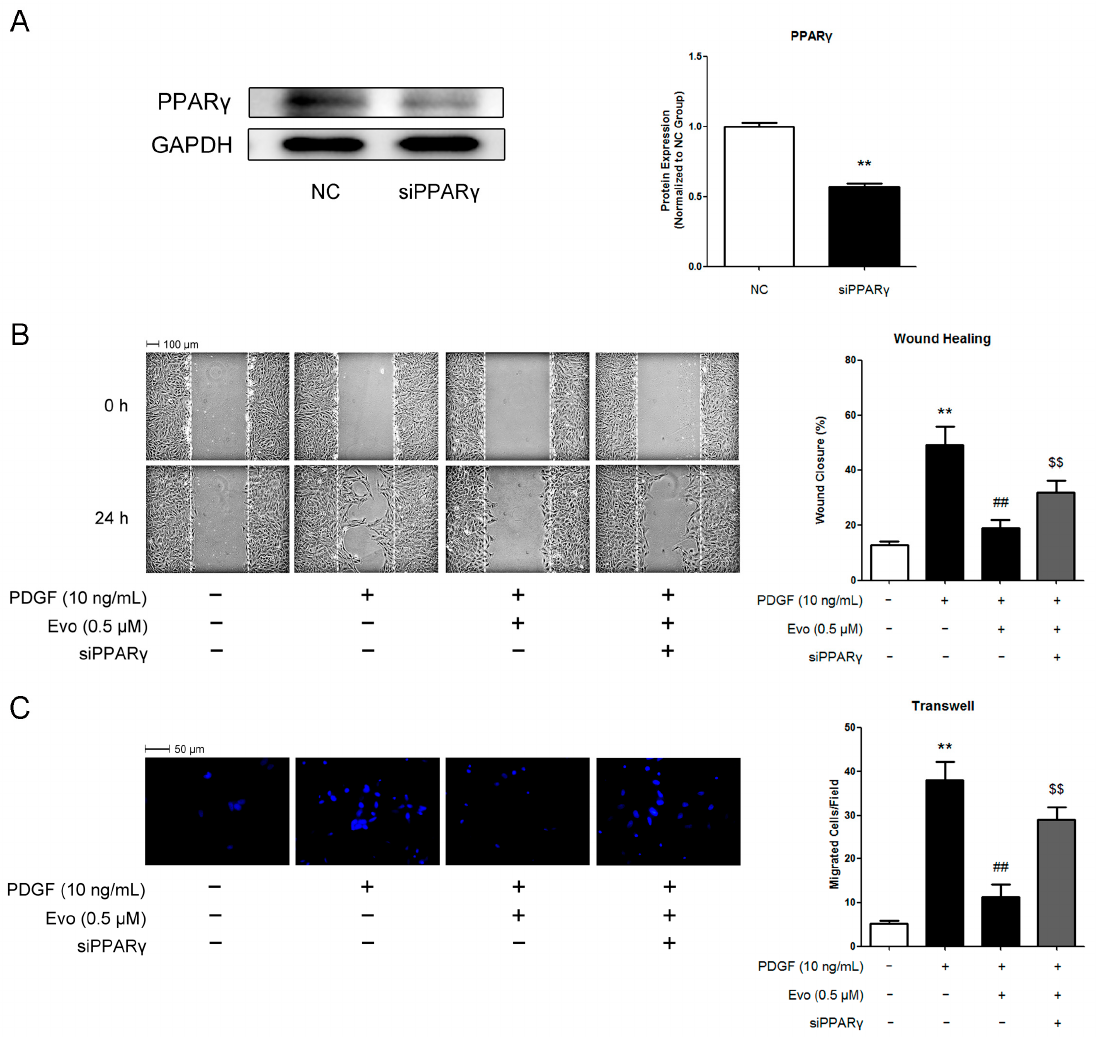
Figure 5. Knockdown of PPAR γ by its specific siRNA alleviated the inhibitory effects of evodiamine on PDGF-BB-stimulated VSMC migration. ( A ) Knockdown efficiency of siRNA tested by Western blot; ( B , C ) Quantification of VSMC migration. VSMCs were transfected with scrambled siRNA (negative control, or NC) or siRNA against PPAR γ (siPPAR γ ). 24 h after transfection, cells were pretreated with 0.5 μ M evodiamine for 6 h and then stimulated with 10 ng/mL PDGF-BB for 24 h (wound healing assay, B ) or 6 h (transwell assay, C ). In Panel C, blue color indicates cell nuclei stained with DAPI. Evo, evodiamine. Data are represented as mean values ± SD of three independently prepared samples each with five measurements. ** p < 0.01 compared with the control group; ## p < 0.01 compared with the PDGF-BB-stimulated group; $$ p < 0.01 compared with the group treated with both evodiamine and PDGF-BB.